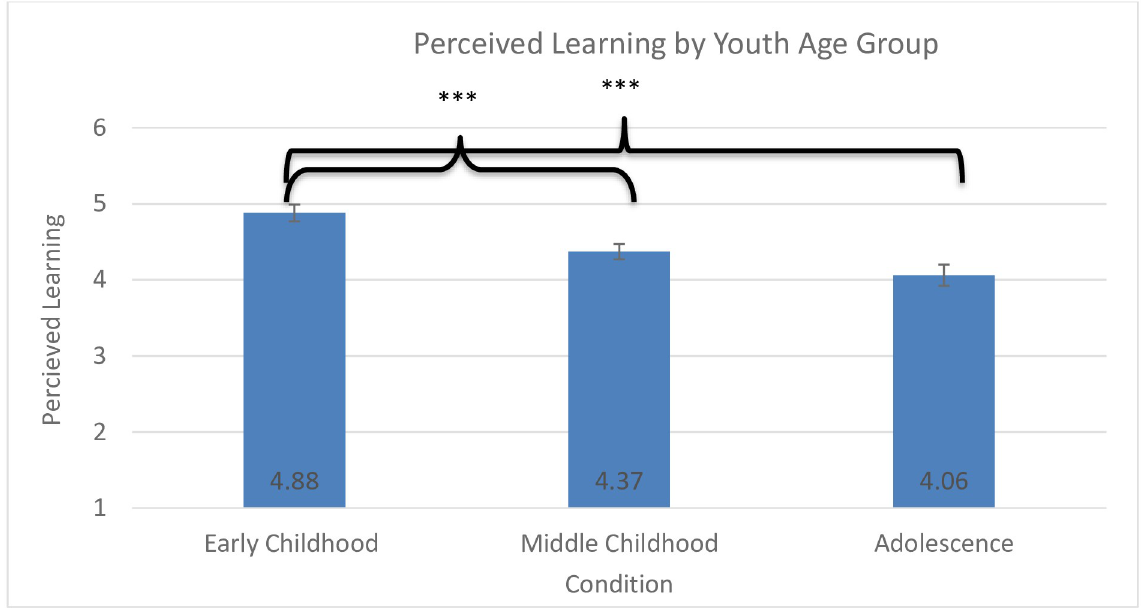
Fig 3. Perceived learning by youth age group. � p < .005, �� p < .01, ��� p < .001.